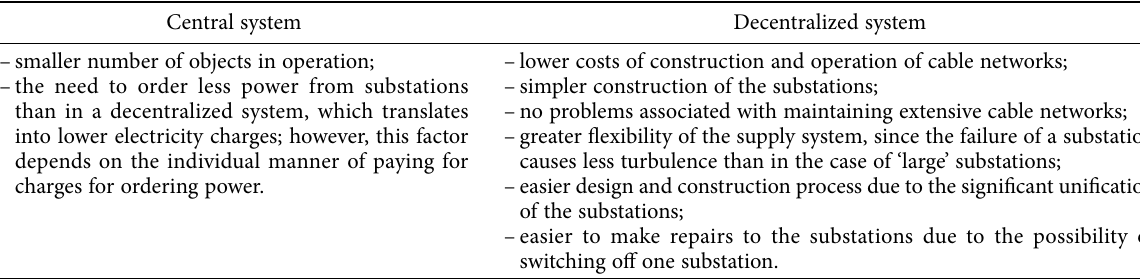
Table 1. The advantages of central and decentralized power supply systems Central